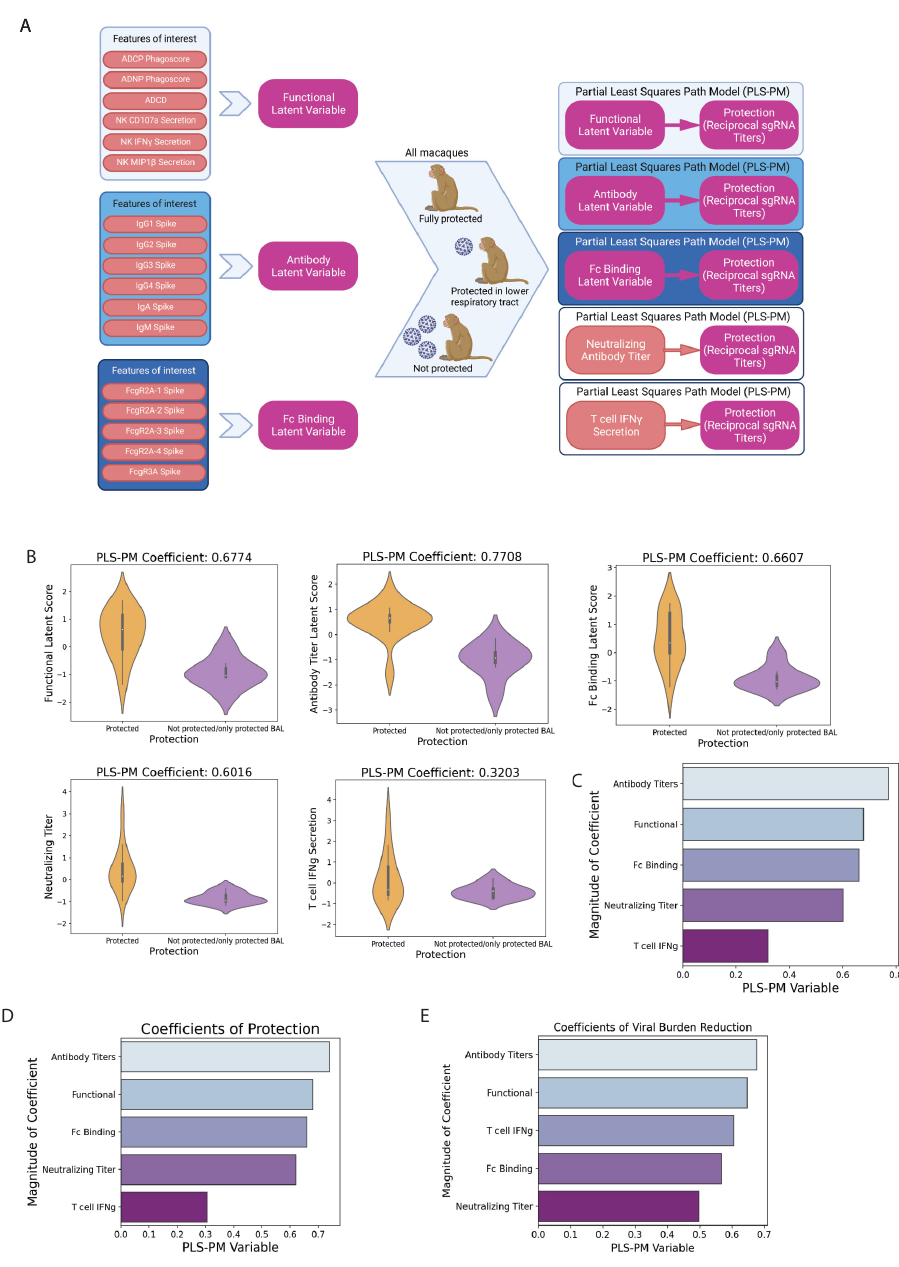
Fig 6. Combined variable analysis identifies key combinatorial correlates of protection. (A) Diagram depicting the process for computing latent variable coefficient scores with PLS-PM. Five PLS-PM models were computed, and the coefficients compared. Figure created with BioRender.com. (B) Violin plots showing the distribution of latent scores for the functional, antibody titer, and FcR binding features, as determined by PLS-PM, as well as for neutralizing antibody titer and T-cell IFN γ secretion. The white dot represents the median, the thicker bar the IQR, and the thinner bar 1.5 times the IQR in either direction. Thickness of the violin represents the density of a particular region. (C) Barplots showing coefficients for the PLS-PM analyses (D, E) Barplots showing coefficients for 2 PLS-PM analyses: with a binary protection variable (“fully protected” or “partially protected or not protected at all”) (D) and with the protection variable being a combination of the AUC of cumulative viral titers measured at day 10 by both nasal swab and BAL (E). This figure can be generated using the data and code deposited in the “src” folder of https://github.com/ dzhu8/Ad26-Dose-Down. Instructions to do so can be found in the README file. AUC, area under the curve; BAL, bronchoalveolar lavage; IFN γ , interferon gamma; IQR, interquartile range; PLS-PM, partial least squares path